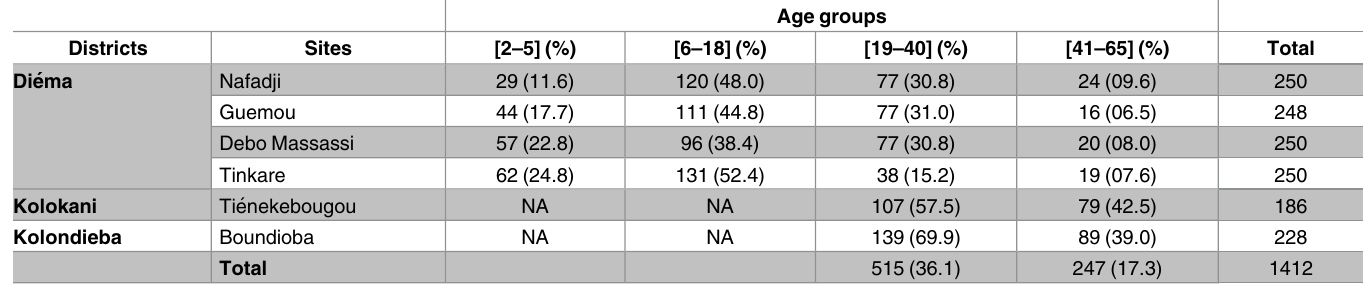
Table 1. Age distribution of enrolled participants, by districts and by sites.